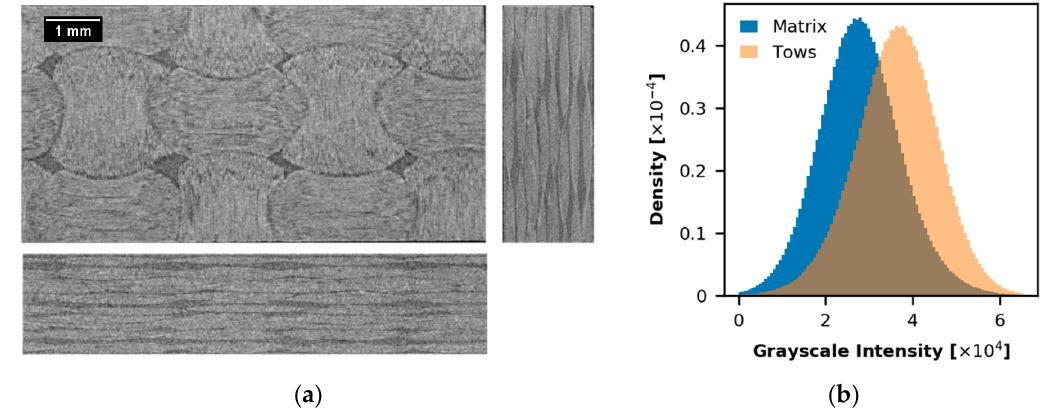
Figure 2. ( a ) Top, front, and side (reconstructed) slices of the input µ-CT image (size in voxels: 368 × 972 × 1723, physical size: 1.8 × 4.9 × 8.6 mm 3 , voxel size ~5 µm); ( b ) Intensity histograms.